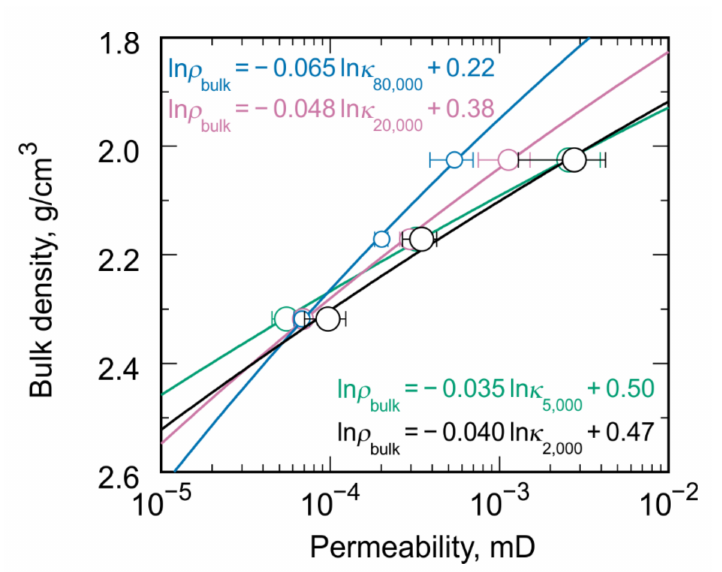
Figure 9. Permeability (mD) of 10X permeated by SGW at hydraulic gradients of 2000–80,000 m/m as a function of bulk density. Circles and solid lines represent measured values and fitted